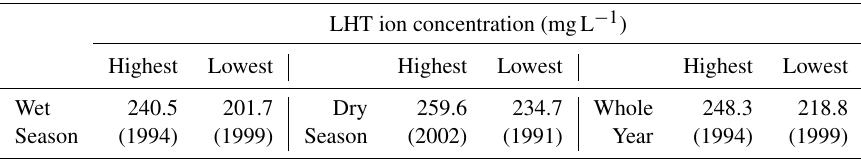
Table 2. The highest and lowest ion concentration in the wet season, dry season, and throughout the whole year for the LHT station 1988– 2002.